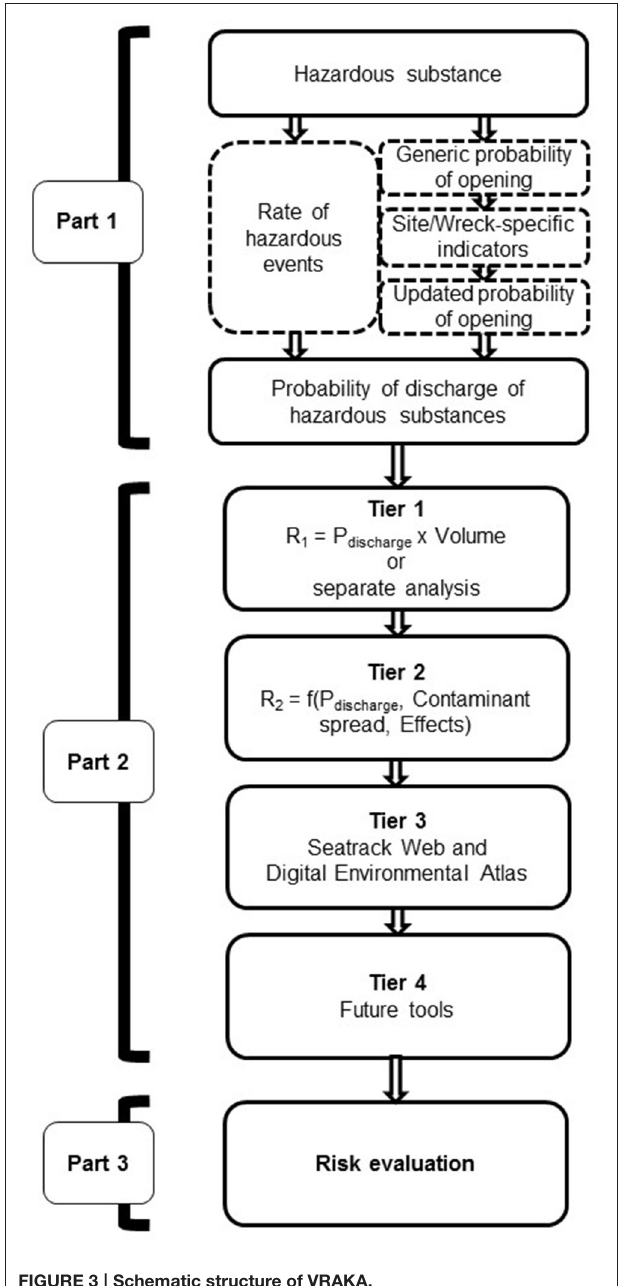
FIGURE 3 | Schematic structure of